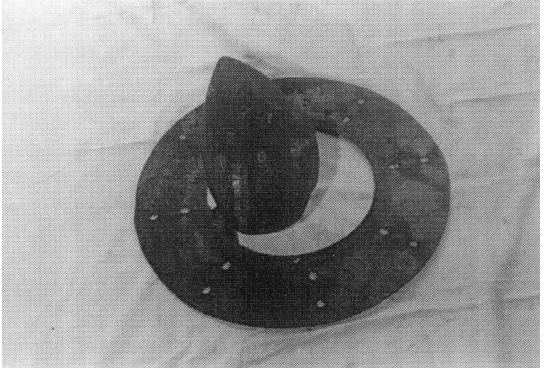
Fig. 14. A photographic view of the plate fractured at its edge; ex- plosive charge quantity = 80 grams of PEK-1. Stand off = 150